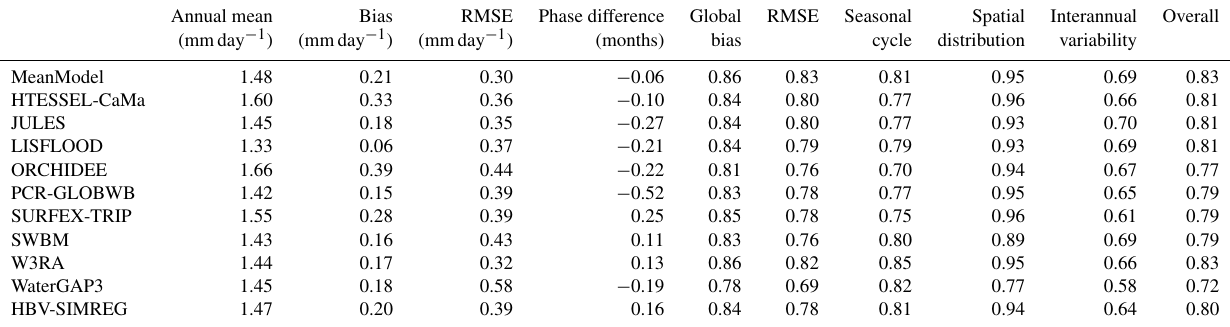
Table B3. Diagnostic summary for evapotranspiration: model vs. GLEAM-V3B. Annual mean